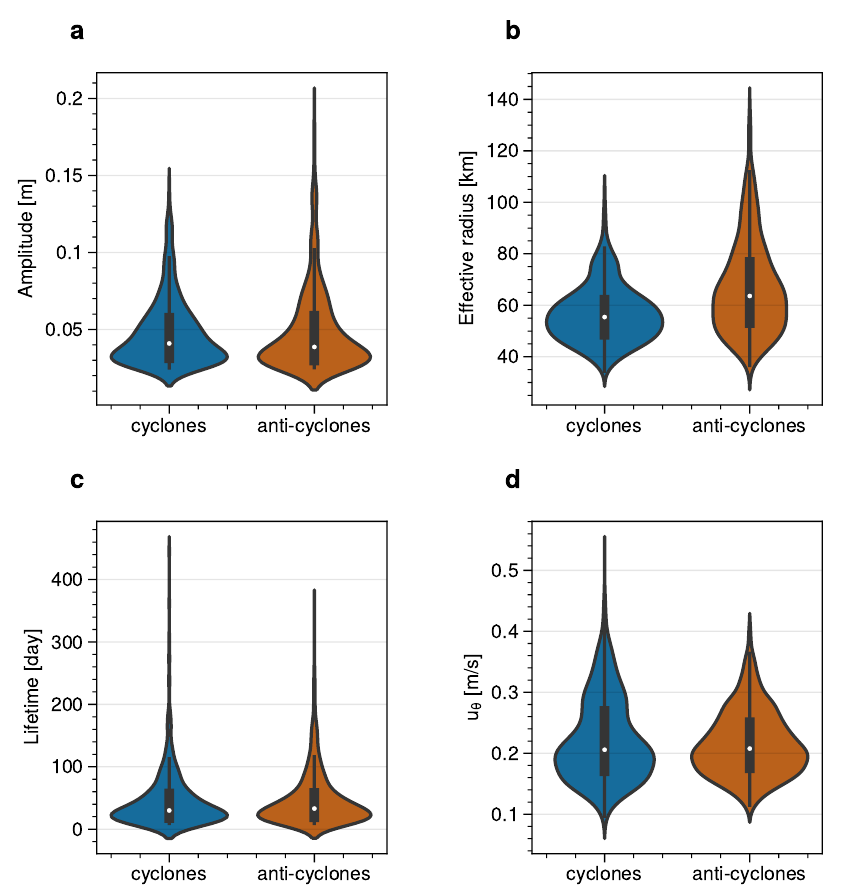
Figure 10. A visualization of the statistics of ( a ) amplitude, ( b ) effective radius, ( c ) lifetime and ( d ) average speed for local eddies in the South Brazil Bight. These violin plots show the extreme values, median (white circle), first and third quartiles (black rectangle), and the distributions of the data. Mean and standard error statistics for these, as well as for remote eddies, are shown in Table